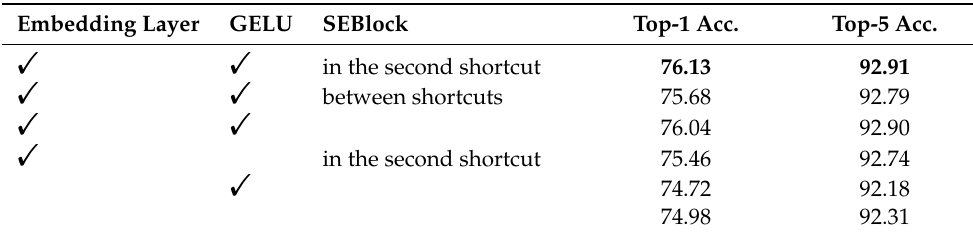
Table 4. The performance results of the designed models on ImageNet. The symbol (cid:33) indicates that this module is used in this